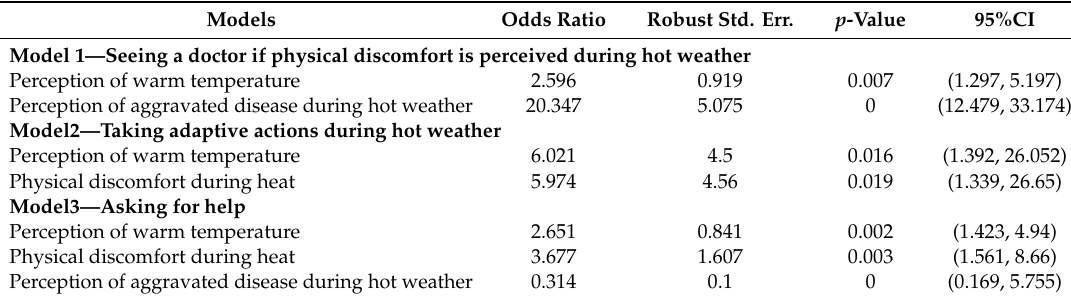
Table 4. Logistic regression results for the